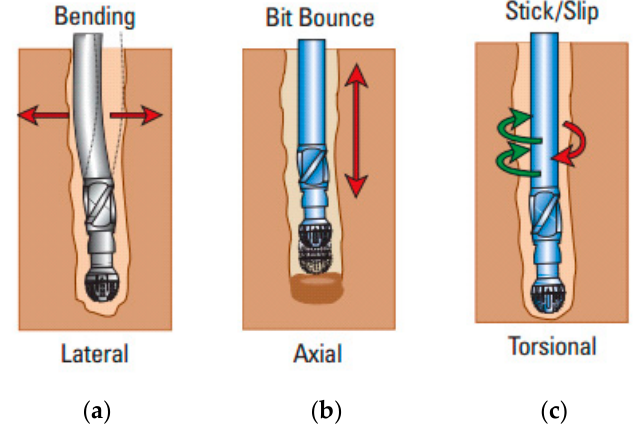
Figure 4. Types of vibrations: ( a ) axial, ( b ) lateral, ( c ) torsional.